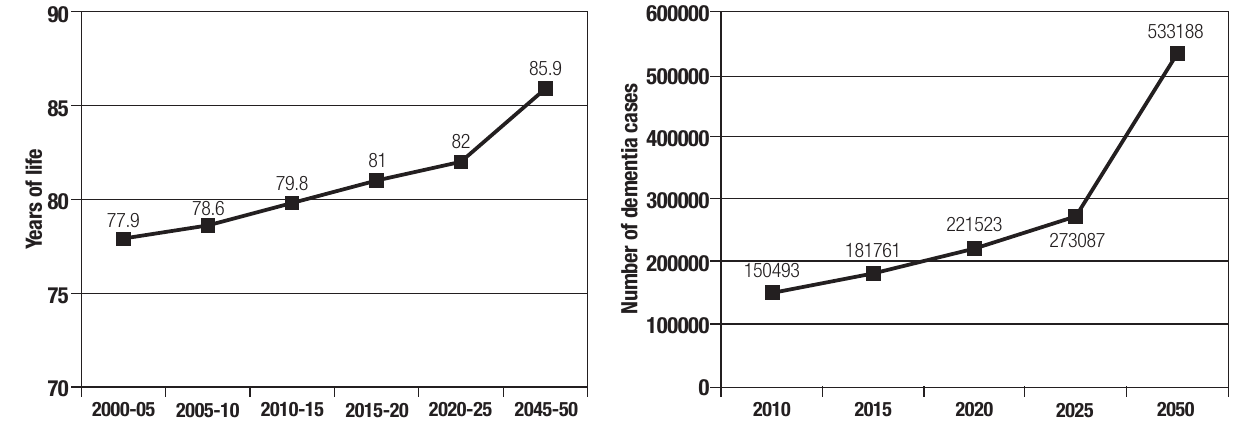
Figure 2. Life expectancy at birth and estimated number of dementia cases. Chile 2002-2050